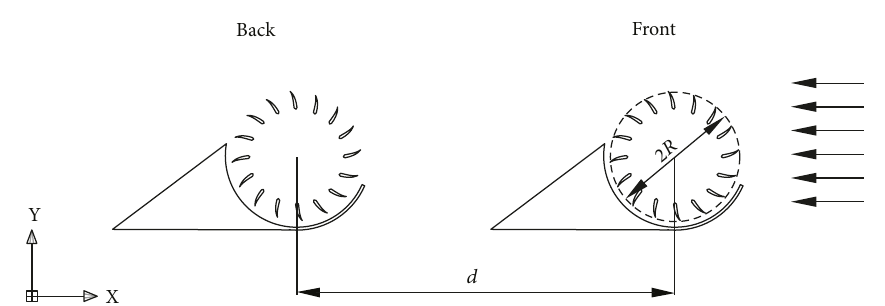
Figure 5: De fi nition of distance between front and rear wings of the tandem fan